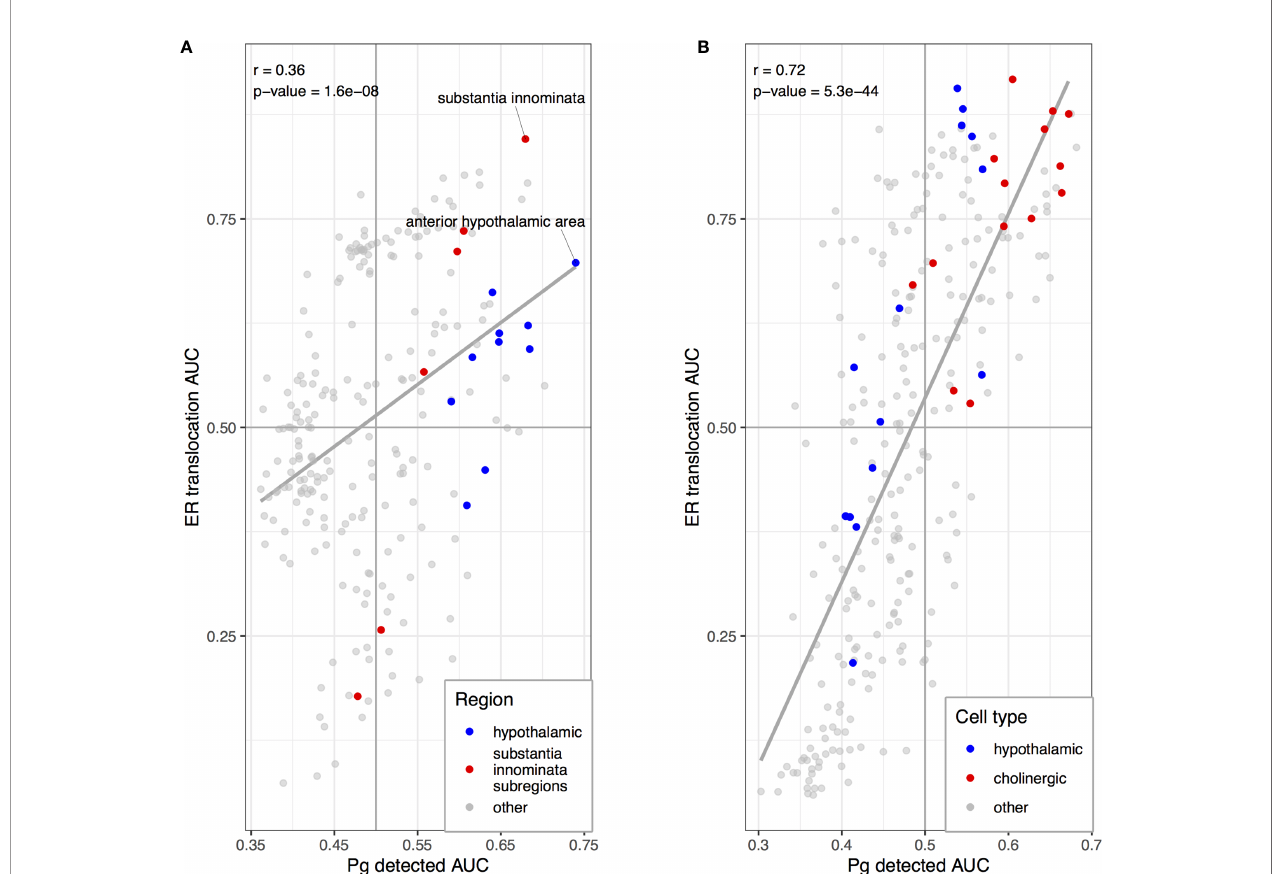
FIGURE 5 | Scatterplots comparing anatomical enrichment of ER translocation genes (y-axis) and up-regulated in samples with P. gingivalis reads (x-axis). AUC values are plotted to show enrichment in the human brain atlas (A) and the mouse nervous system (B) . Hypothalamic regions and transcriptomic cell type clusters are marked in blue. Cholinergic clusters, substantia innominata and its subregions are marked in red. Fitted linear regression lines for all points are shown in